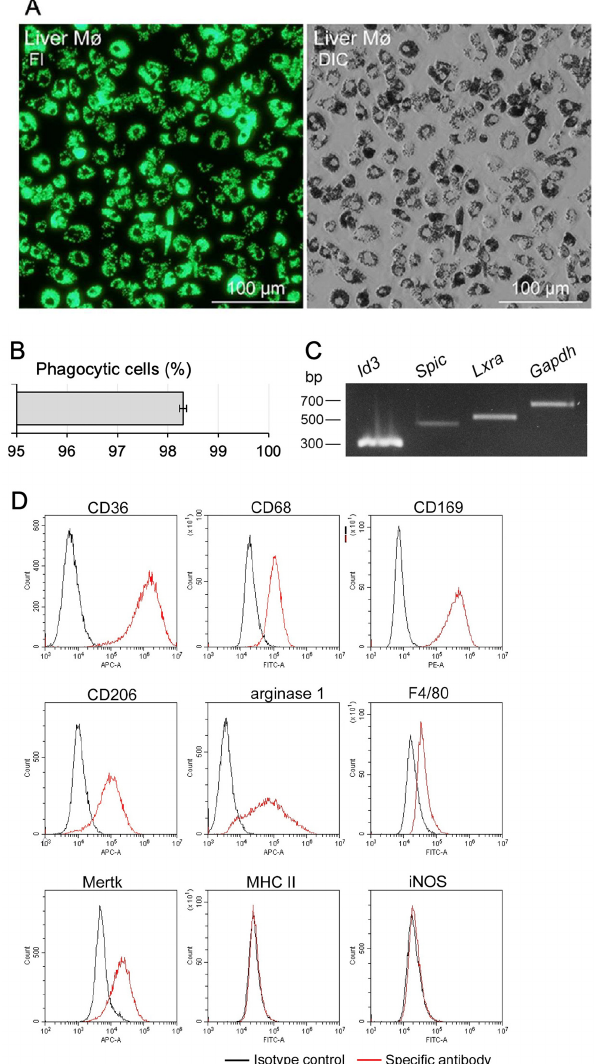
Figure 2. Propagated liver Mø using the mixed culture have identical properties to Kupffer cells. ( A ) Phagocytic properties assessed using incubation with fluorescent beads in liver tissue-resident Mø segre- gated by adhesion to bacteriological Petri dishes. Green fluorescence image (Fl, left panel) and differential interference images of the same fields (DIC, right panel). ( B ) Bar graph representing the percentage of propagated liver Mø in cells adherent to bacteriological Petri dishes, presented as mean ± SD. More than 690 cells per sample were counted, and the percentage of phagocytic cells in three mice was determined from three independent experiments. ( C ) Expression profile of transcription factors in propagated liver Mø determined using RT-PCR. Liver Mø clearly express Id3 , Spic , and Lxra similar to Kupffer cells. ( D ) Representative histograms showing the expression profiles of nine Mø markers in propagated liver Mø using flow cytometry (red histogram, specific antibody; black histogram, isotype control). The cell suspen- sions were treated with a fluorochrome-labeled test antibody or the same amount of fluorochrome-labeled isotype control antibody. The characteristic expression patterns of CD206- and arginase 1-positive, as well as MHC II- and iNOS-negative, indicate polarization of propagated liver Mø to the M2